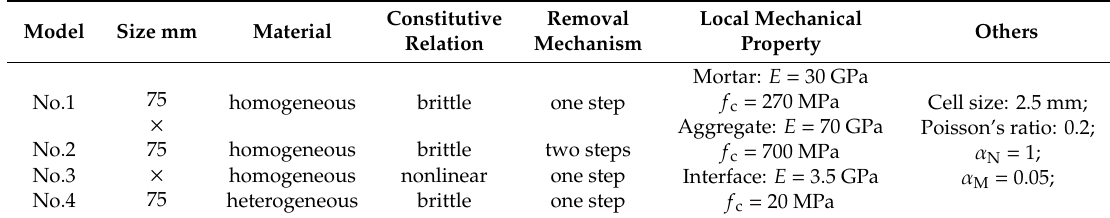
Table 9. The input parameters for the numerical analysis.